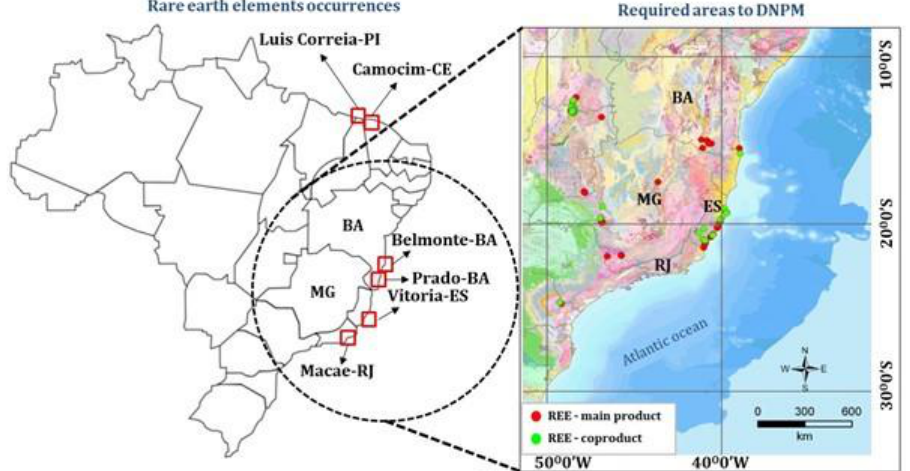
Figure 1. Rare earth elements (REEs)-bearing mineral occurrences along the Brazilian coastline and areas licensed by the National Department of Mineral Production (DNPM) for extraction of REEs. Adapted from [15,16].